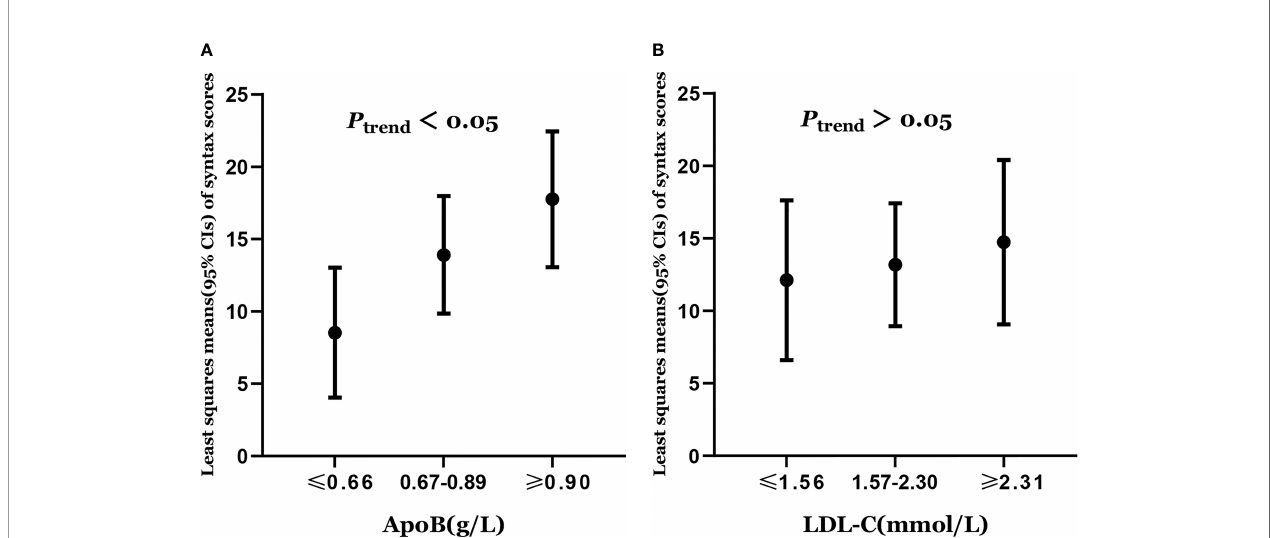
FIGURE 2 | (A) Least squares means of syntax scores was estimated according to the levels of apoB. (B) Least squares means of syntax scores was estimated according to the levels of LDL-C. Dots represents the least squares means of syntax scores, up and down lines respectively represent the upper and lower limits of the 95% con fi dence interval for the least squares means. The least squares means of syntax scores was estimated using generalized linear model with adjustment of age (years), sex (female or male), smoking status (never smoker or smoker), diabetes (no or yes), hypertention (no or yes), total cholesterol, triglycerides, apolipoprotein A1, and lipoprotein